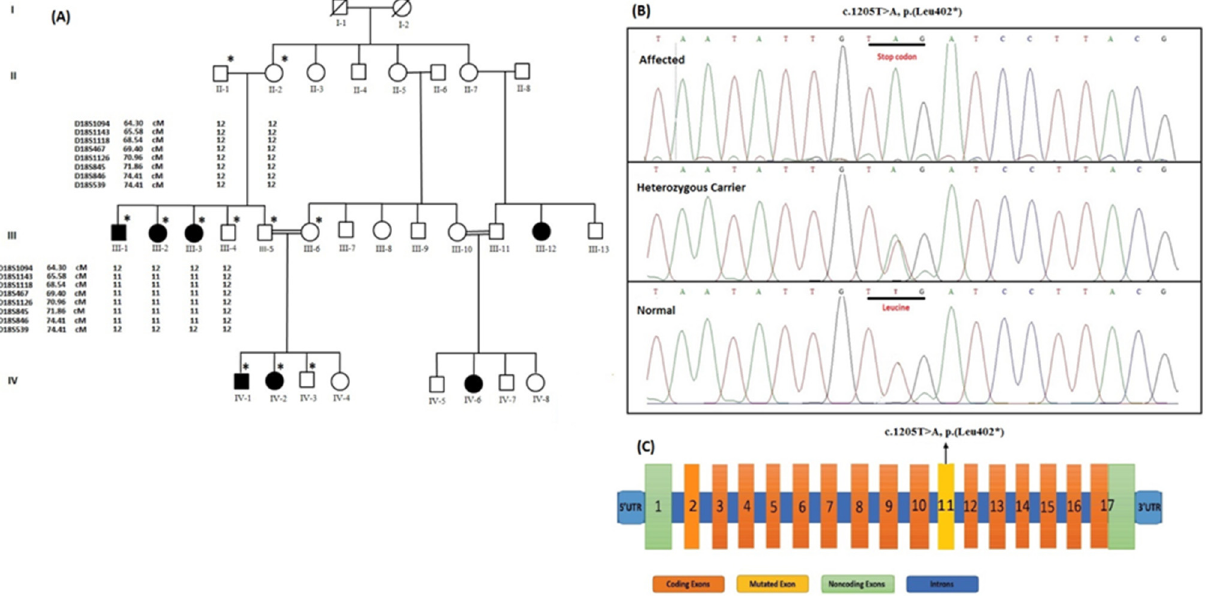
Figure 2. Haplotypes and sequence analysis of the family: ( Panel A ): Pedigree of consanguineous family segregating DMC in autosomal recessive manner. Affected and unaffected individuals are represented by filled and empty symbols, respectively. An asterisk (*) sign over the symbol shows the individuals from which blood is drawn. A consanguineous union is represented by a double line. On the symbols, a cross line denotes a deceased person. Each symbol is followed by the haplotypes of the closely related microsatellite markers on chromosome 18q21.1, with haplotypes 11 and 12 denoting homozygous and heterozygous individuals, respectively. ( Panel B ): Chromatogram showing sequence analysis of the DYM gene. Upper panel shows affected member, middle indicates heterozygous carrier state, while the lower one indicates wild-type individual. Mutation involved transition of T to A replacing Leucine by a stop codon TAG at 402 position. Asterisk (*) shows stop codon. ( Panel C ): Schematic representation of all the 17 exons of the DYM gene. Orange color indicates coding exons (2–17), pale green color depicts noncoding exon (1), while yellow color of exon 11 shows point of mutationc.1205T>A, p.(Leu402*). Asterisk (*) shows stop codon.